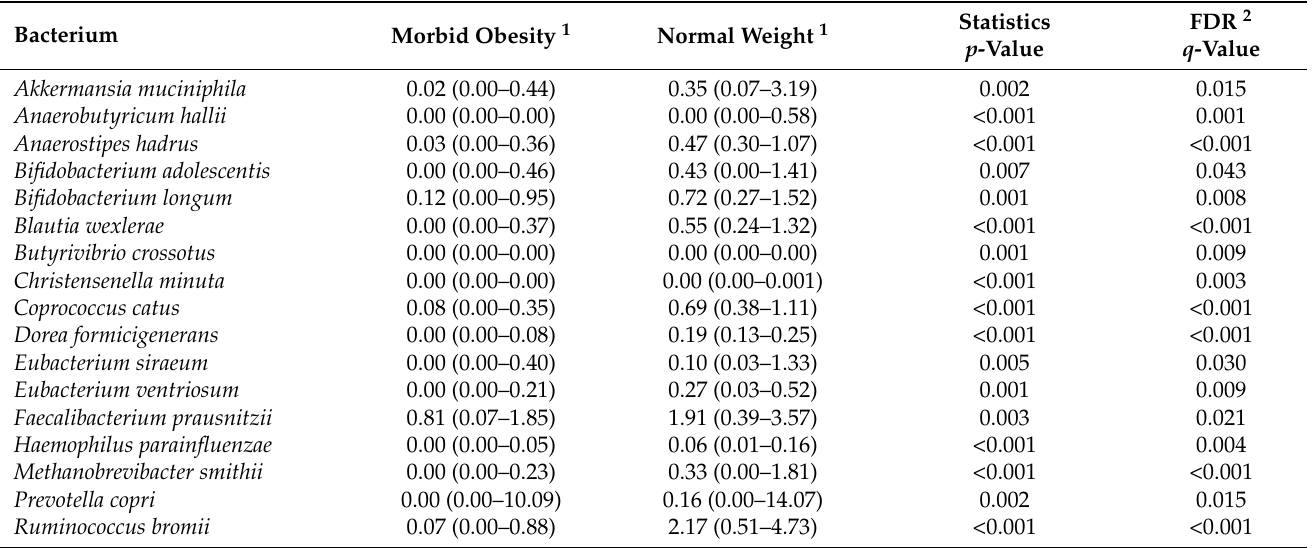
Table 2. The bacteria showing significant differences between subjects with morbid obesity and normal body weight after adjusting for multiple testing.